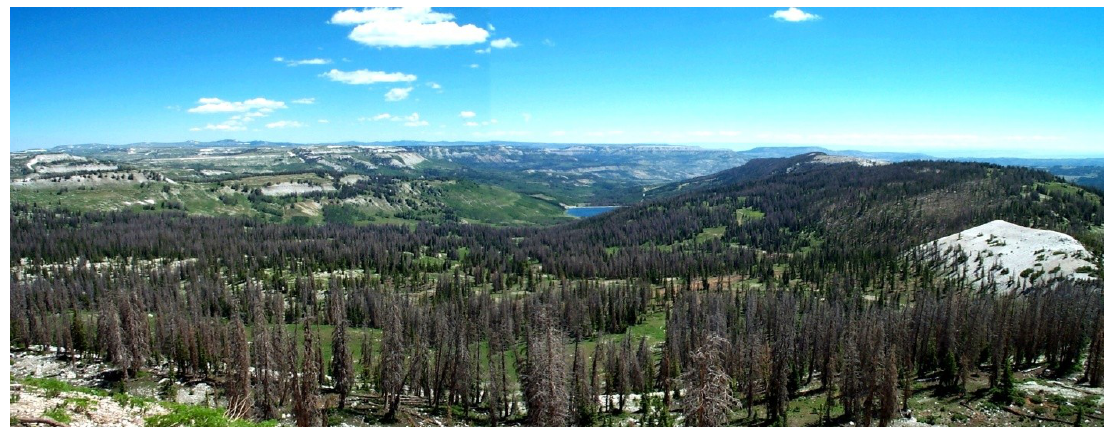
Figure 1. Spruce beetle outbreak on the Wasatch Plateau (1985–1995), Manti-LaSal National Forest, Utah (Photo: A. Steven